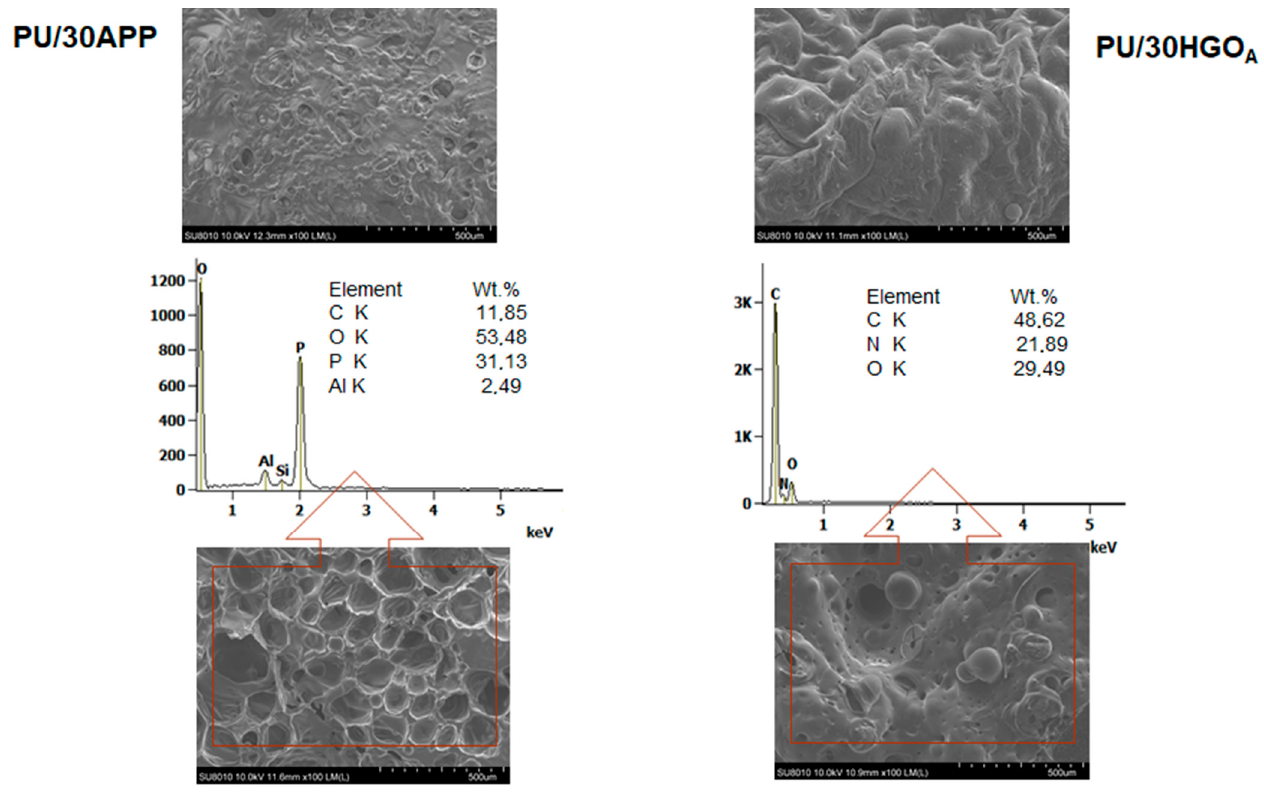
Figure 11. SEM images of PU/30APP and PU/30HGO A after CC tests (outer and inner part of char) and EDS results.